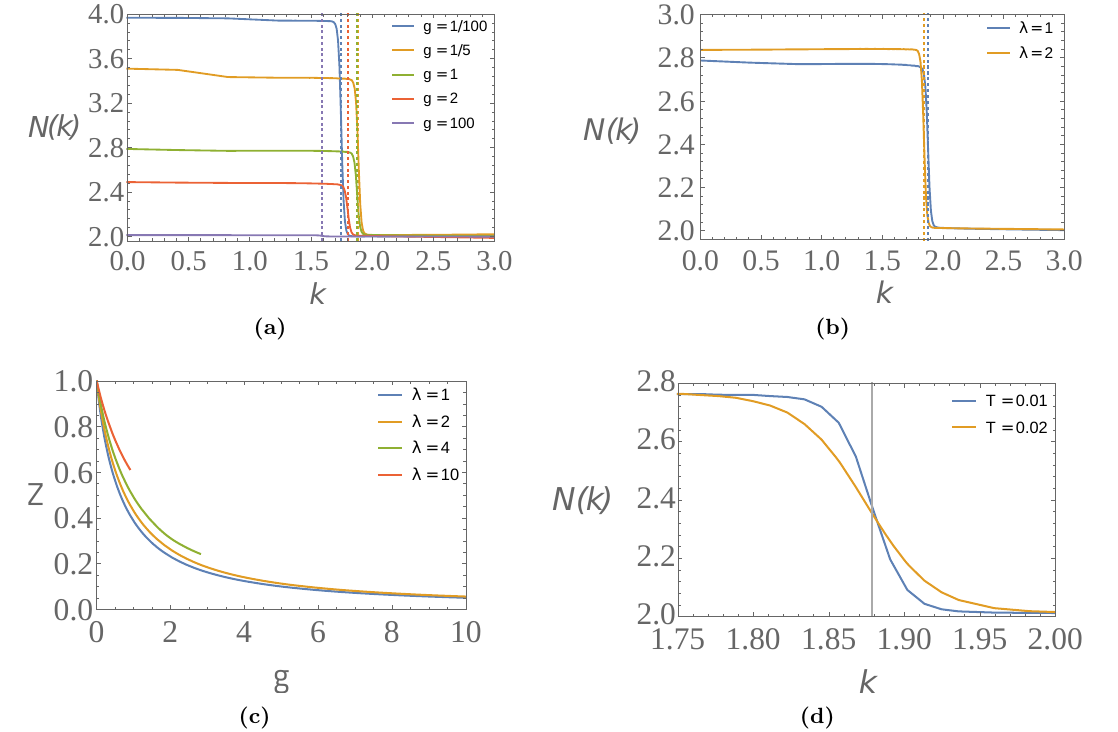
Figure 12 . The dependence of the momentum distribution function on (a) the coupling g , (b) the coupling (cid:21) and (d) the temperature, and (c) the dependence of the quasiparticle residue on g and (cid:21) . In all plots the chemical potential is (cid:12)xed to (cid:22) = 2 and in all plots except for (d), the temperature is (cid:12)xed to T = 1 = 100. In (a) (cid:21) = 1, in (b) g = 1 and in (d) g = (cid:21) = 1. The dotted lines in (a) and (b) denote the Fermi momenta of the corresponding curves of the same colors, as calculated from the spectral functions. In (d), the gray line denotes the location of the Fermi surface, which does not depend on